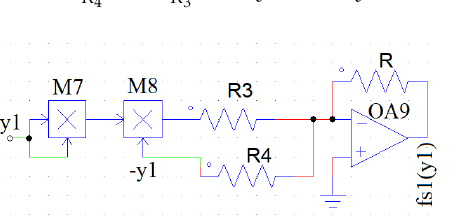
Figure 13. The equivalent circuit diagram of the force due to the magnetic spring f S1 ( y 1 ) . The resistance values are: R 3 = 2.50 k Ω , R 4 = 18.26 k Ω , R = 100 k Ω . OA 9 is the Op-Amp, M 7 and M 8 are the two multipliers. (Color